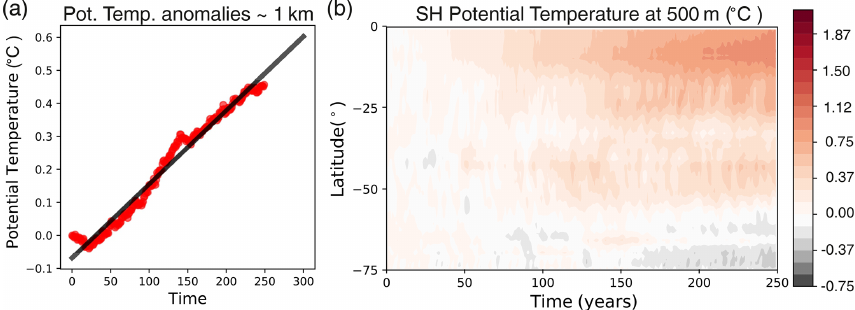
Figure 3. Southern Hemisphere seawater potential temperature anomalies: (a) depth-averaged LIG_hosing–LIG anomalies over the top 1045m of the water column and linear fit, (b) Hovmöller diagram of LIG_hosing–LIG anomalies at 500m depth.